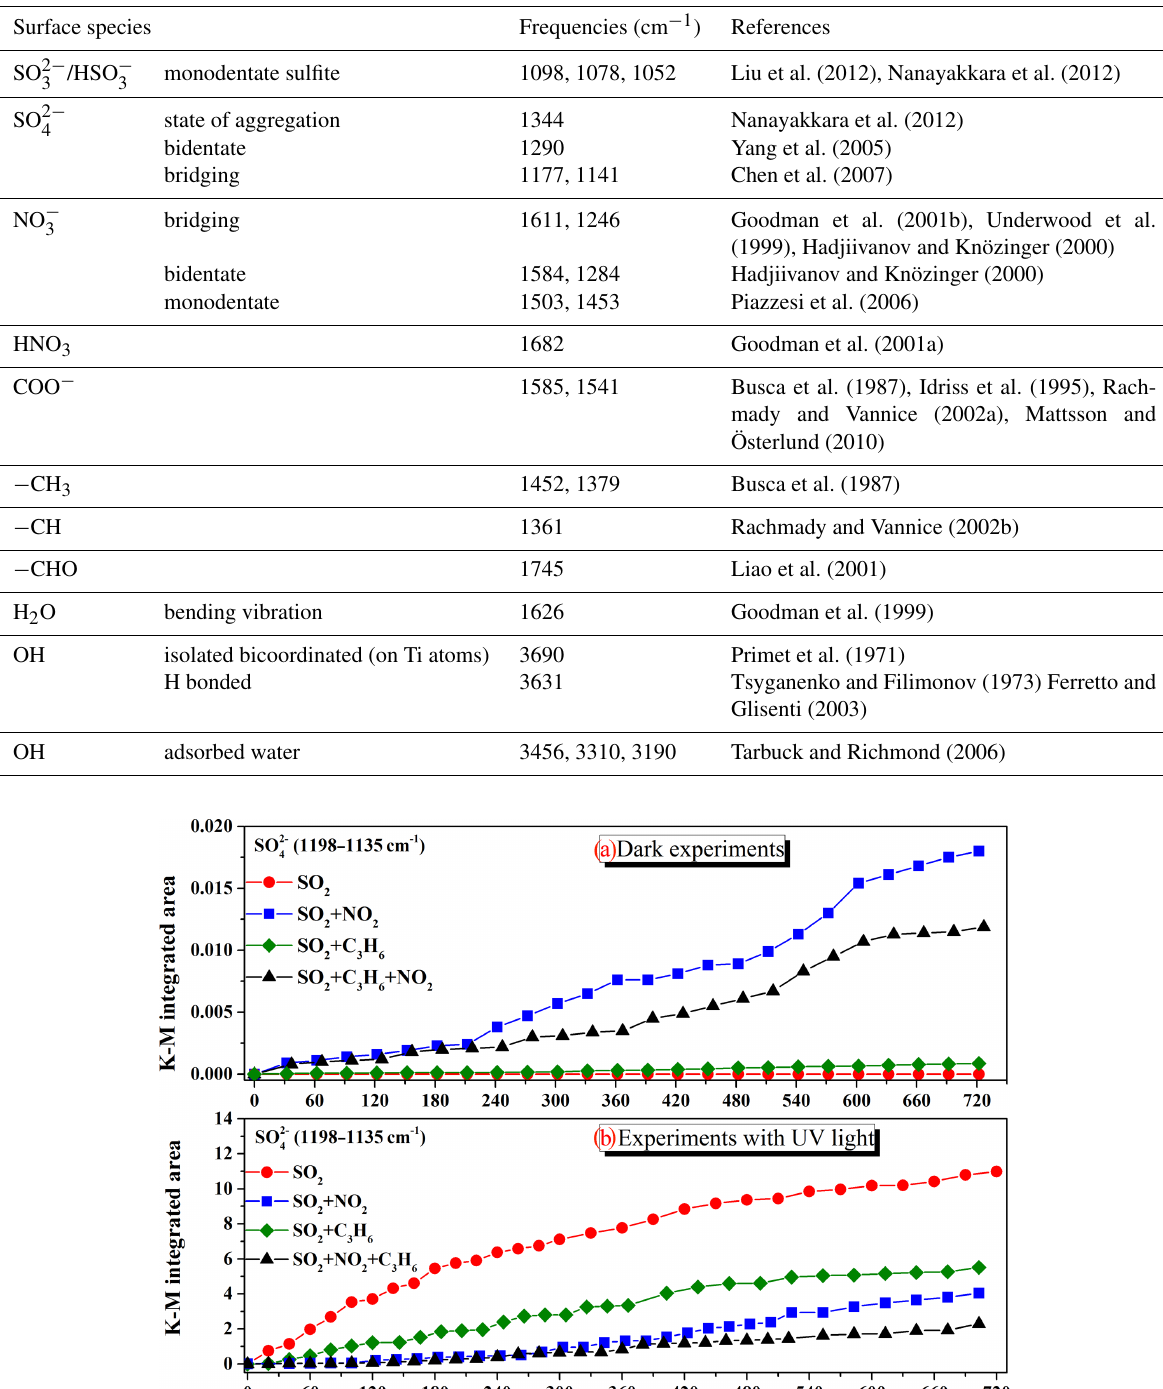
Table 1. Vibrational frequencies of chemisorbed species formed on TiO 2 . Surface species